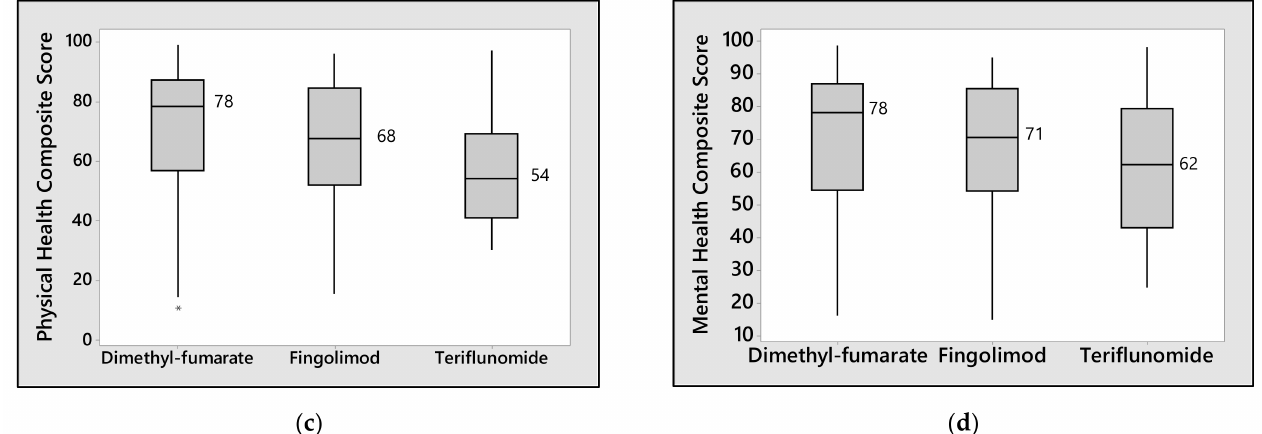
Figure 3. Association between MSQoL-54 Composite Scores and pharmacologic treatments: ( a , b ) illustrate the distribution of Physical and Mental Health Composite Scores in patients receiving drugs administrated through subcutaneous injection. ( c , d ) show the distribution of Physical and Mental Health Composite Scores in patients treated with oral drugs. Data falling outside the 1st and 3rd quartiles’ range are plotted as outliers of the data (*).